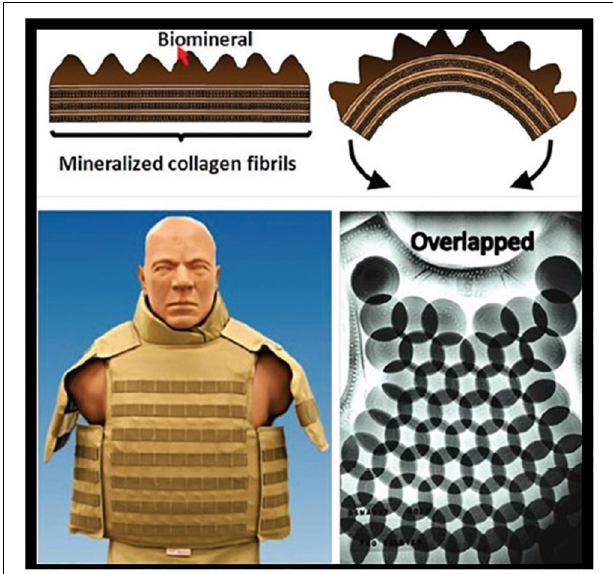
to dissipate energy without allowing penetration of the projectile (Song et al.,